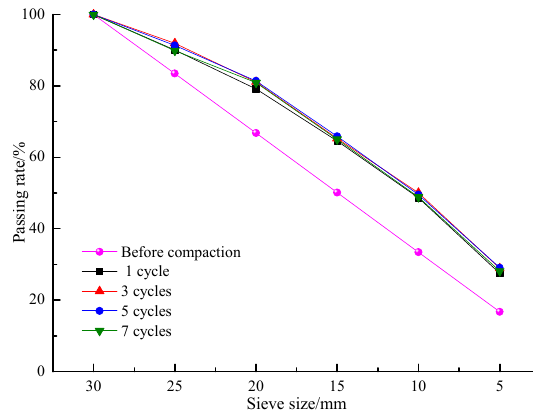
Figure 12. Particle size distributions before, and after, compaction.